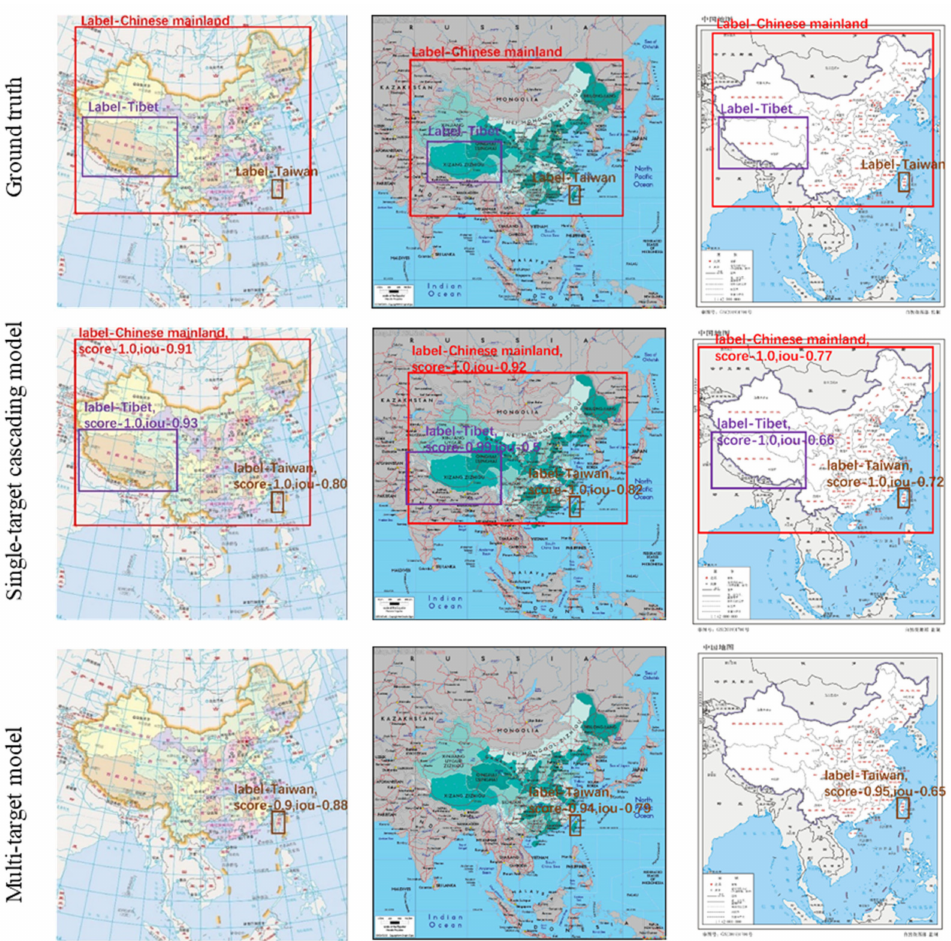
Figure 5. Annotations of different targets in maps ( top row ) and detected results from the single- target cascading model ( middle row ) and multi-target model ( bottom row ). (Different colors of the boxes indicate different types of targets, and labels indicate the target types; score is for classification confidence; IOU is for localization